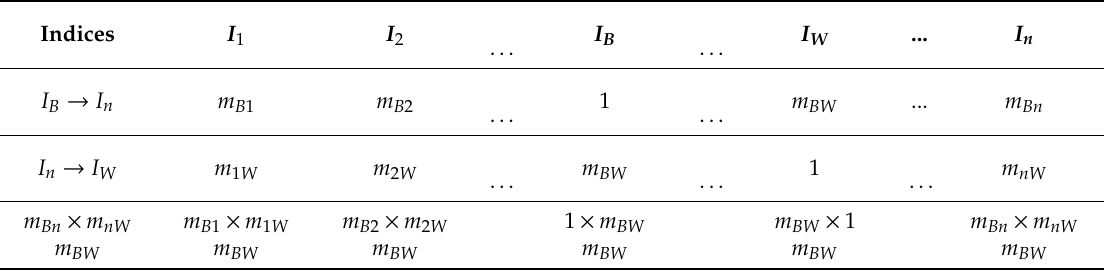
Table 4. Consistency check